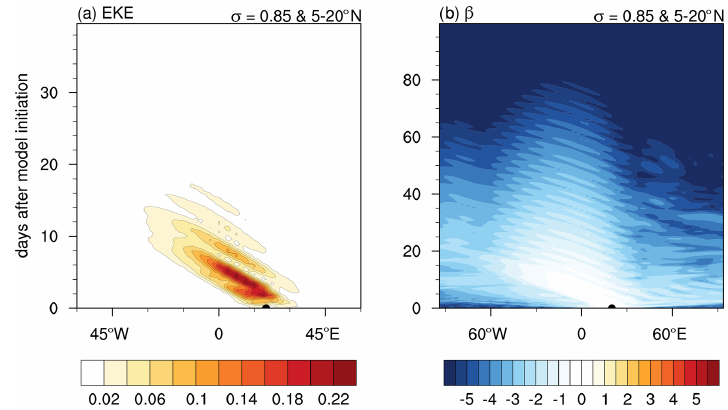
Figure 5. Hovmöller diagram of EKE ( a , Jkg − 1 ) and β (b) at σ = 0 . 65 resulting from fixed heating on the JJAS 1987–2017 composite basic state averaged over 5–20 ◦ N. Note the difference in times shown between panel (a) and panel (b) . The black semicircle at time 0 days represents the location of the initial heating perturbation.